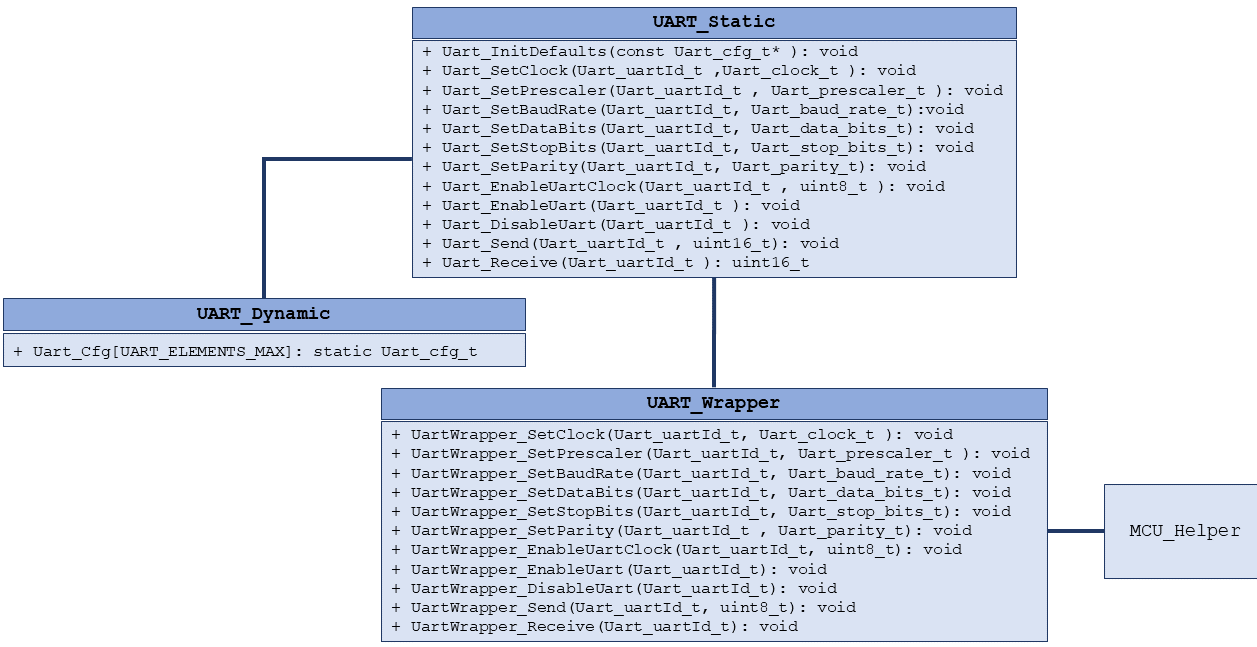
Figure 5. Universal Asynchronous Receiver-Transmitter functions